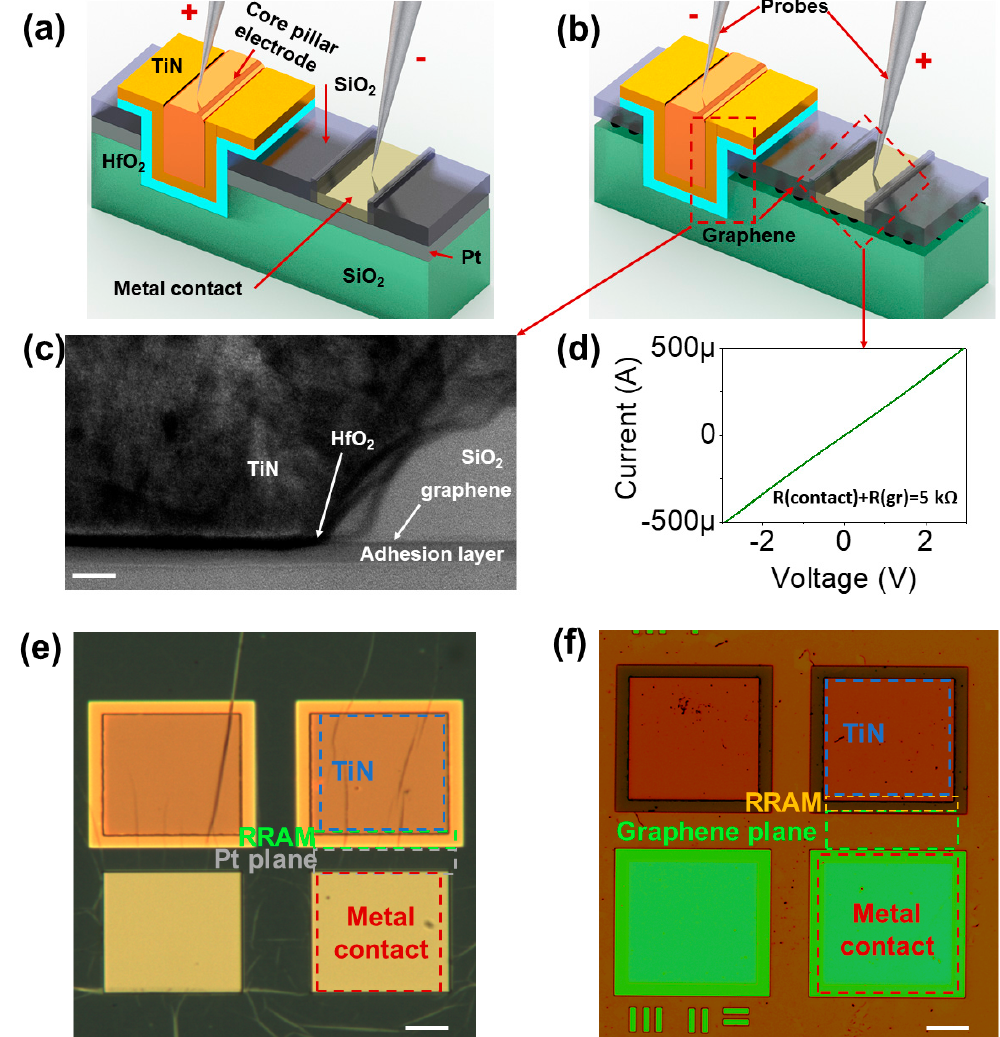
Figure 1. The structure of the single device RRAM in 3D vertical architecture. ( a , b ) The schematic of the VRRAM with conventional metal (Pt) and 2D graphene edge electrodes, respectively. The probes are configured for SET programming operations; ( c ) high-resolution TEM image of the cross-sectional view of the graphene-based VRRAM (Scale bar: 10 nm); ( d ) current response of the sole monolayer graphene sheet with no active memory layer; ( e , f ) microscopic image (top view) of the Pt- and graphene-based VRRAMs (Scale bar: 20 µ